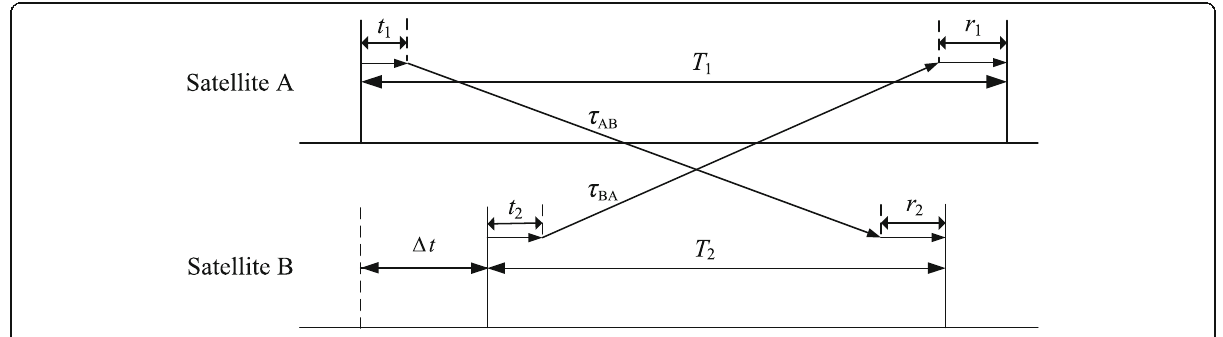
Fig. 1 Principle for inter-satellite two-way clock offset